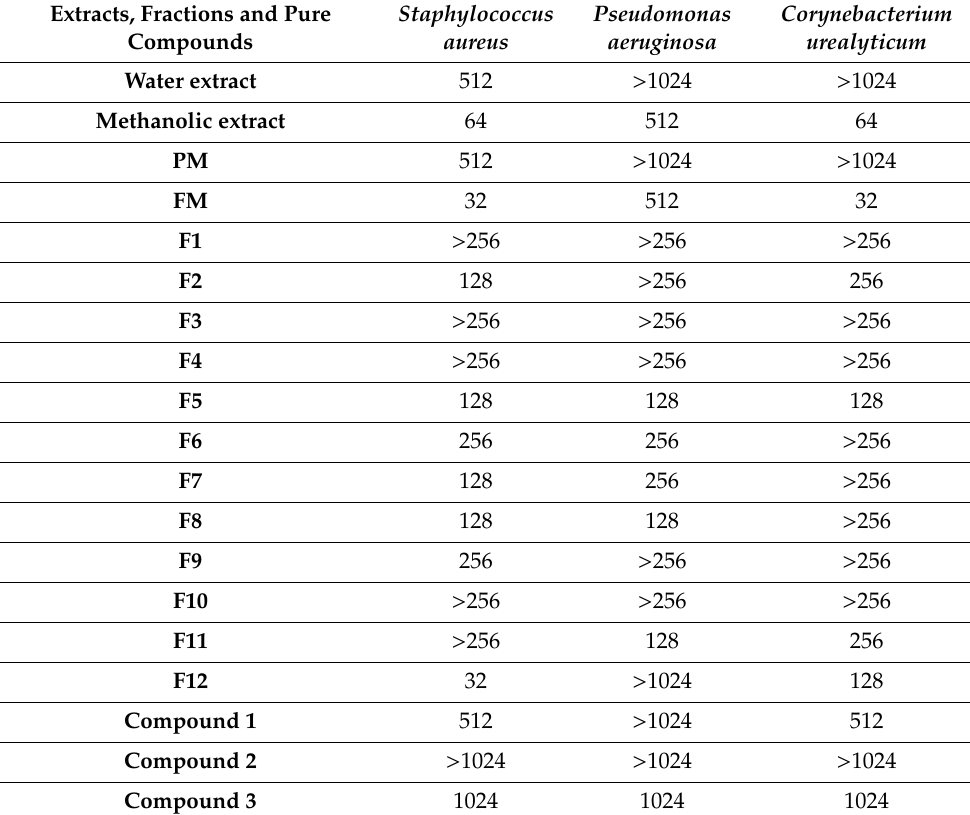
Table 3. Antibacterial activity of extracts and isolated compounds from Acacia seyal bark expressed as MICs ( µ g /